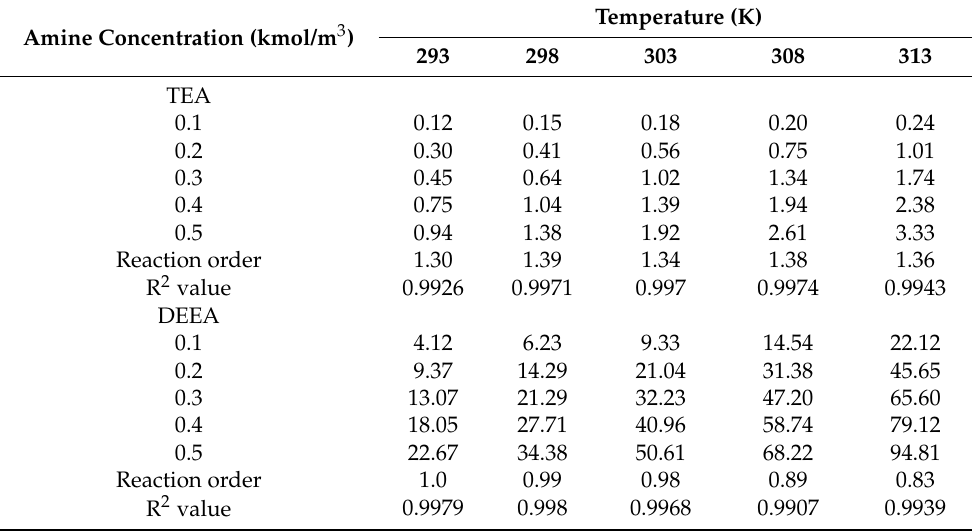
Table A2. The k 2, amine values of CO